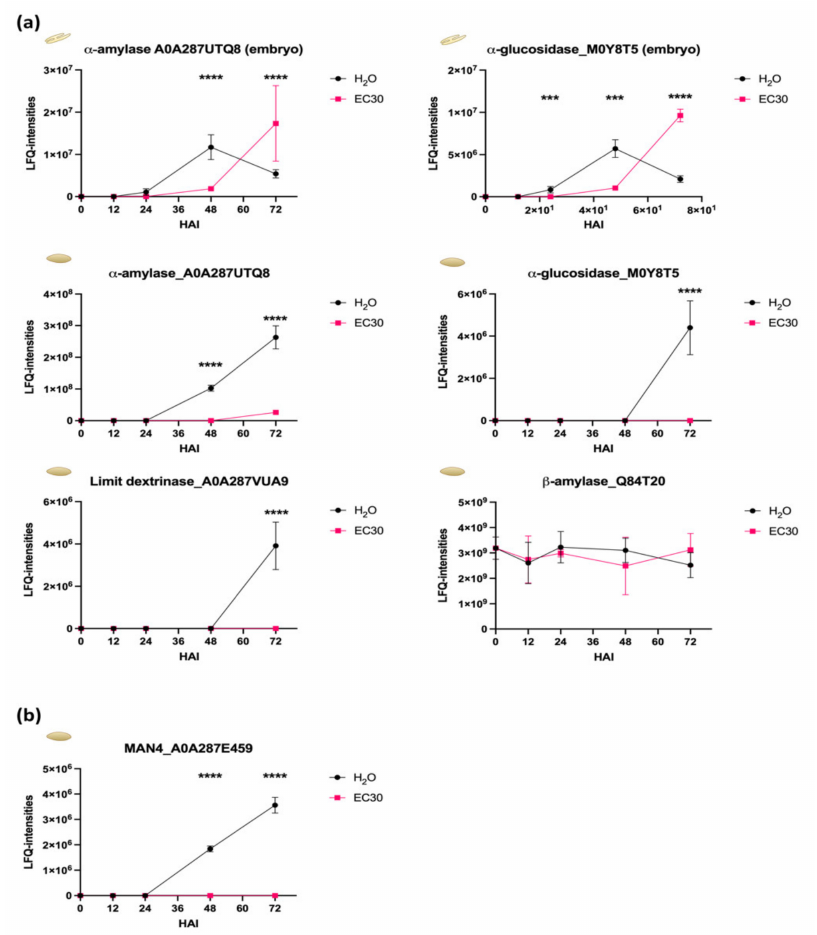
Figure 6. The abundance (LFQ-intensities) of starch and cell wall hydrolysing proteins. ( a ) The abundance of six starch hydrolysing proteins. ( b ) The protein abundance of the cell wall digesting enzyme MAN4 during germination in H 2 O and under EC30 conditions. Statistical analyses: multiple-unpaired t-test; significance is indicated with *** ( p -value ≤ 0.0002) and **** ( p -values ≤